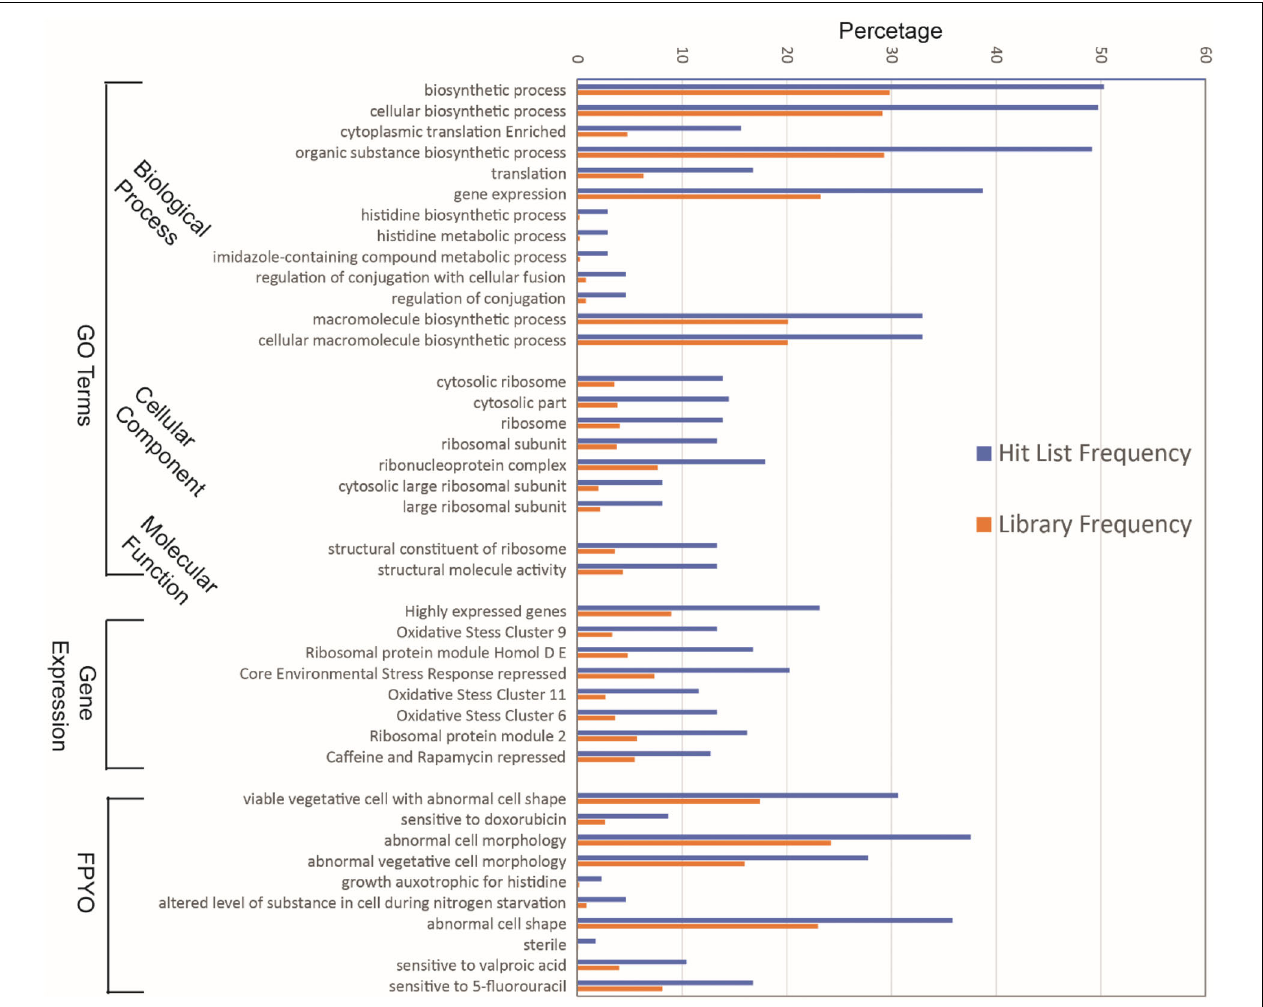
FIGURE 1 | Gene features that are enriched in the ate1 -interacting hit list compared to the library pool. The features of genes were determined by either gene ontology (GO) terms, expression category, or fission yeast phenotype ontology (FYPO).